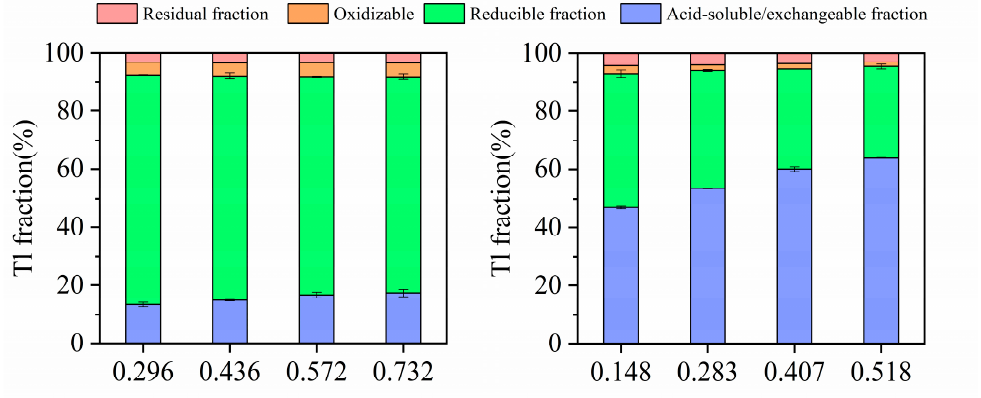
Figure 7. Occurrence forms of Tl(I) elements adsorbed by Fe-WTR and Al-WTR under different adsorption.